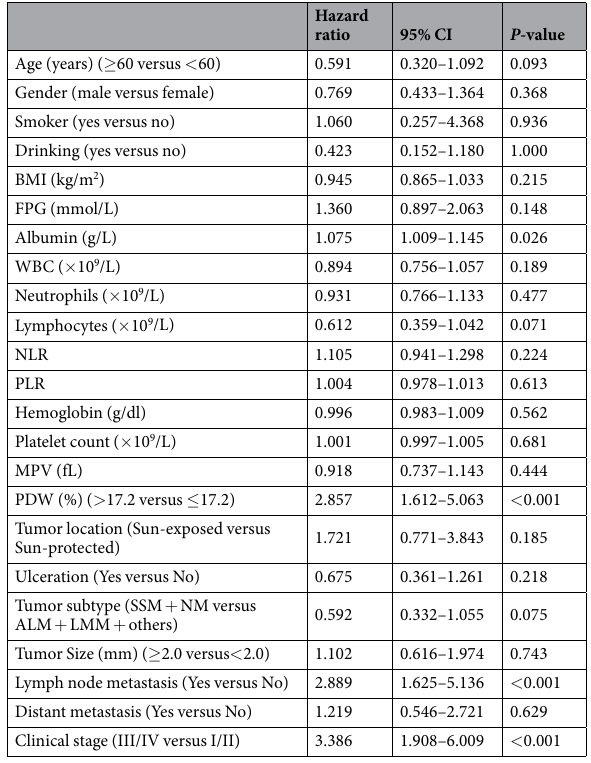
Table 3. Univariate analysis of overall survival in melanoma patients. Abbreviations: see to Tables 1 and 2.